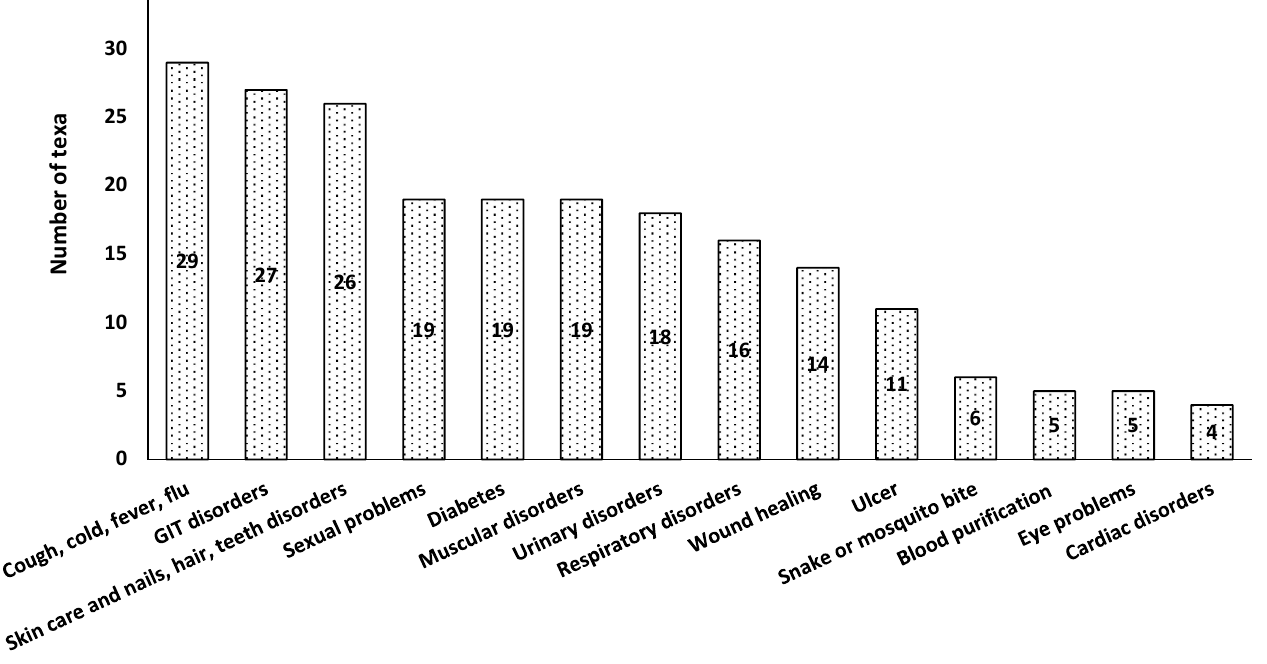
Figure 5. The number of taxa used for treating different ailments.